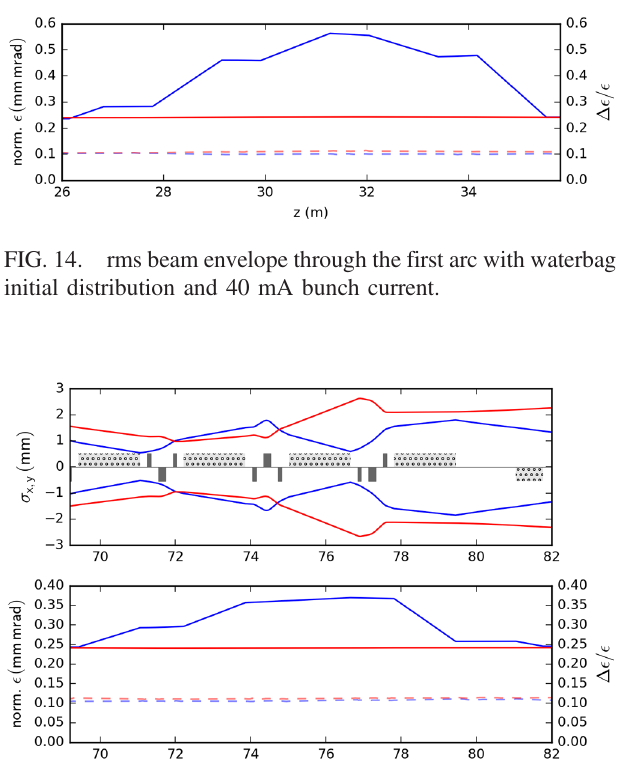
FIG. 17. rms beam statistics from the first-pass LINAC entrance to the second-pass LINAC exit with 20 mA bunch current and a waterbag initial